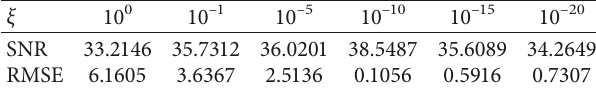
Table 4: The measurement metrics under the parameter ξ